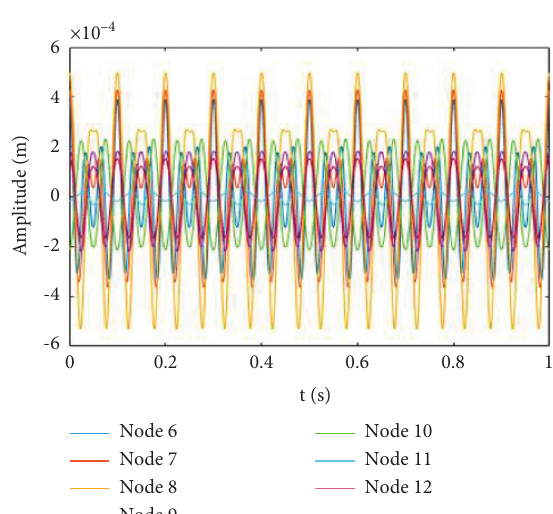
Figure 15: Time-domain unbalanced response of each node in cylinder I.